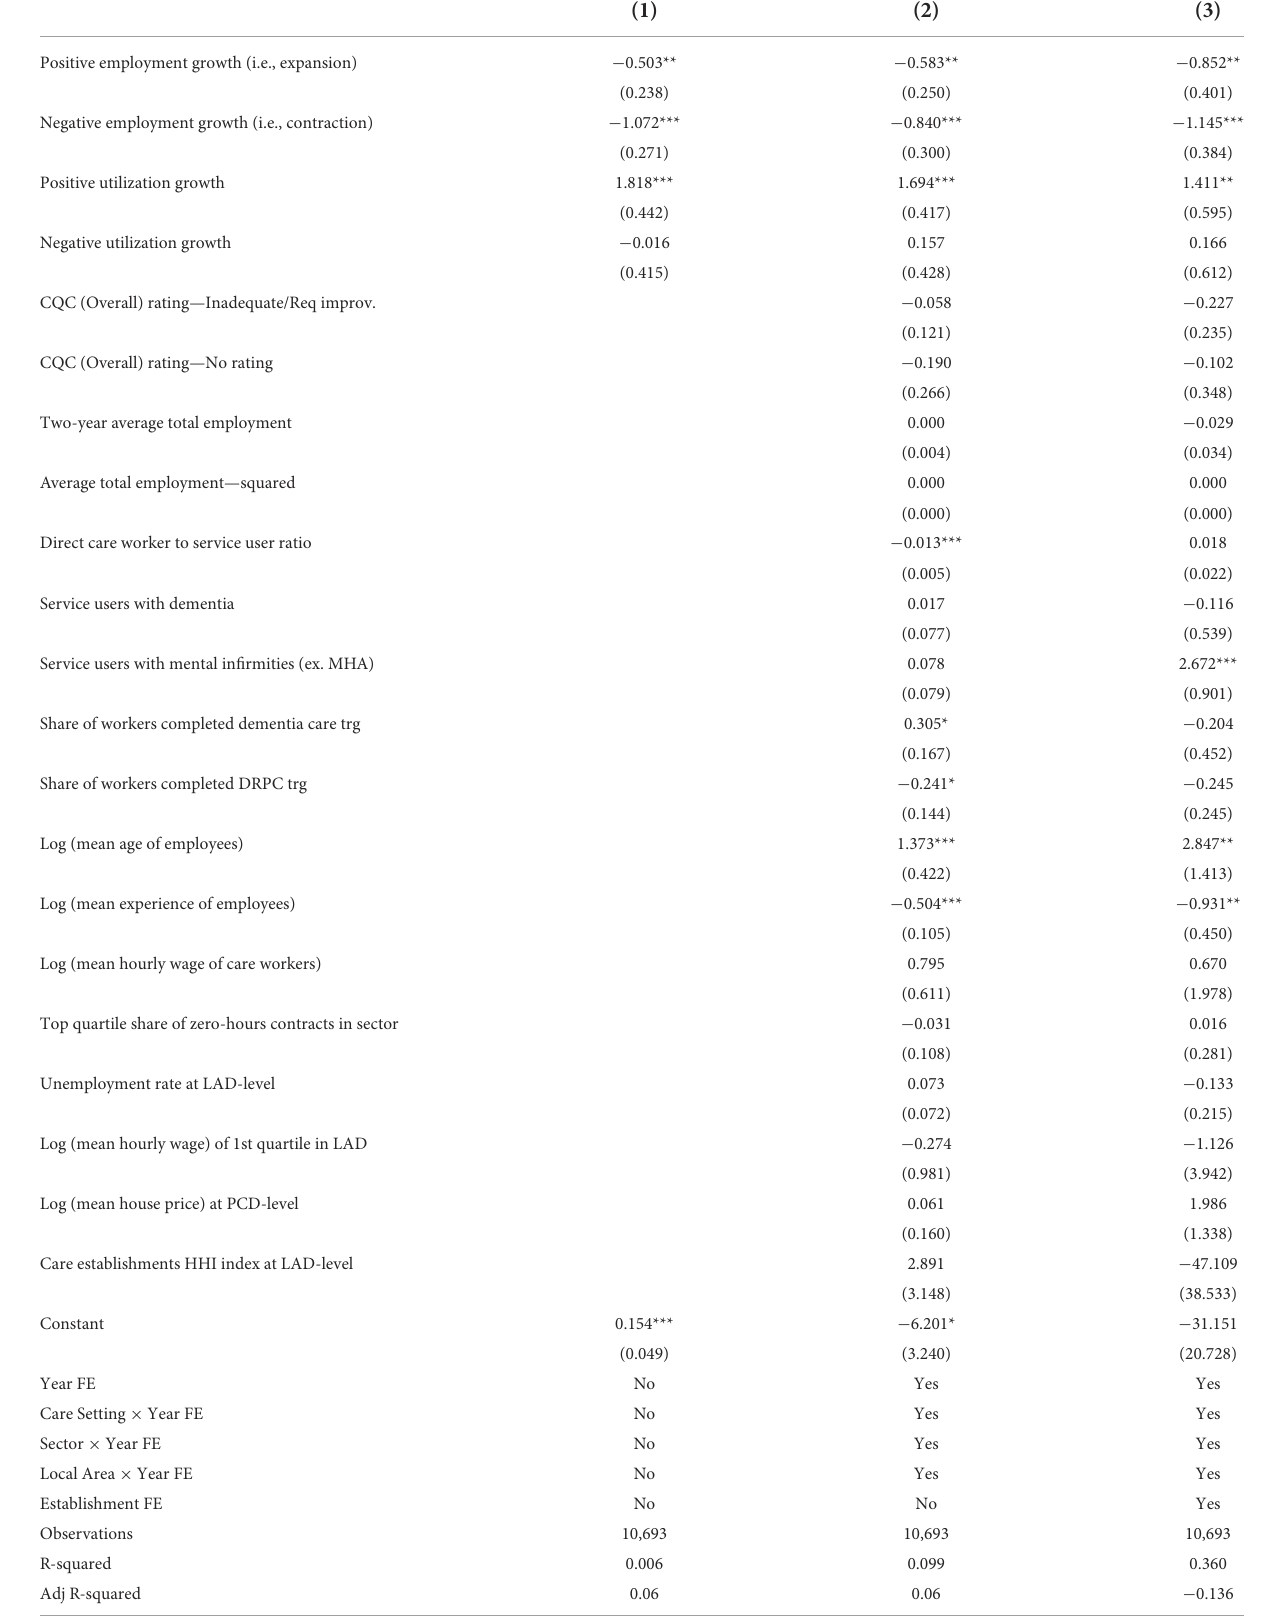
TABLE 5 Estimation results—annual change in